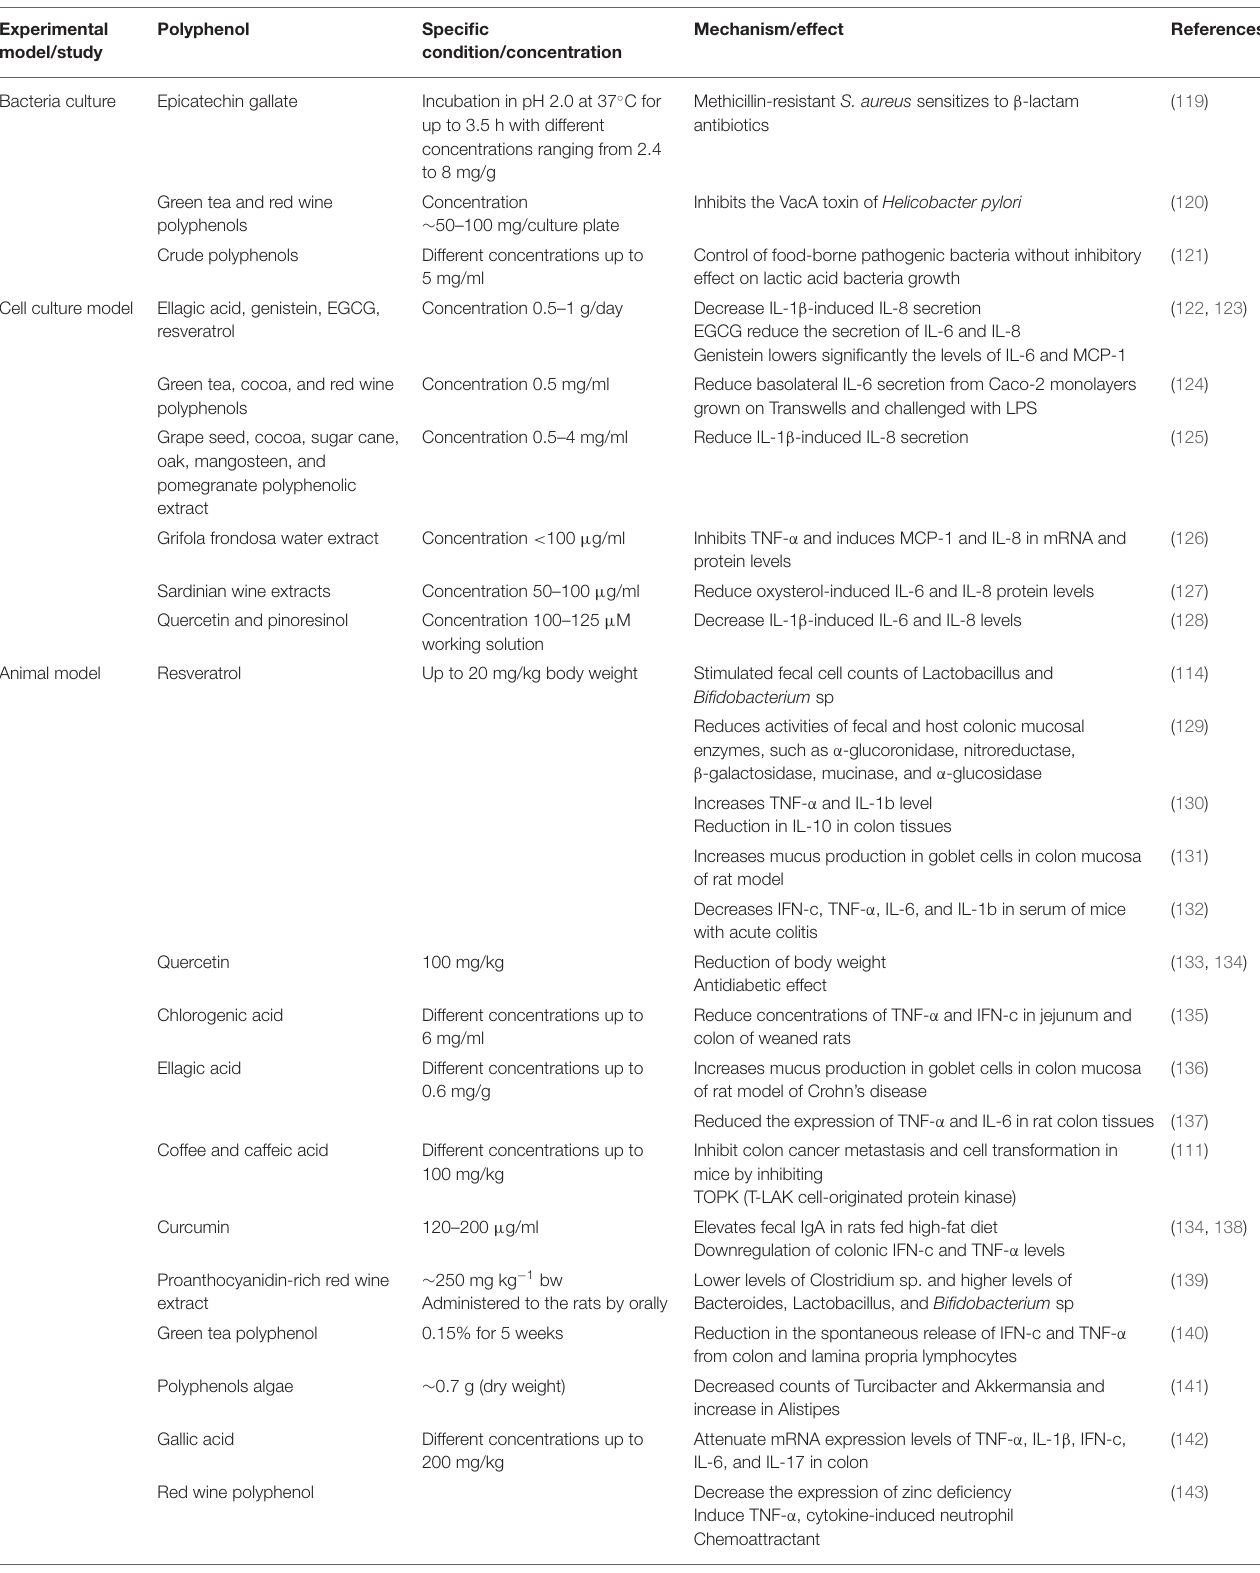
TABLE 3 | Preclinical and human studies with dietary polyphenols on the gut and associated mechanisms (118). Experimental